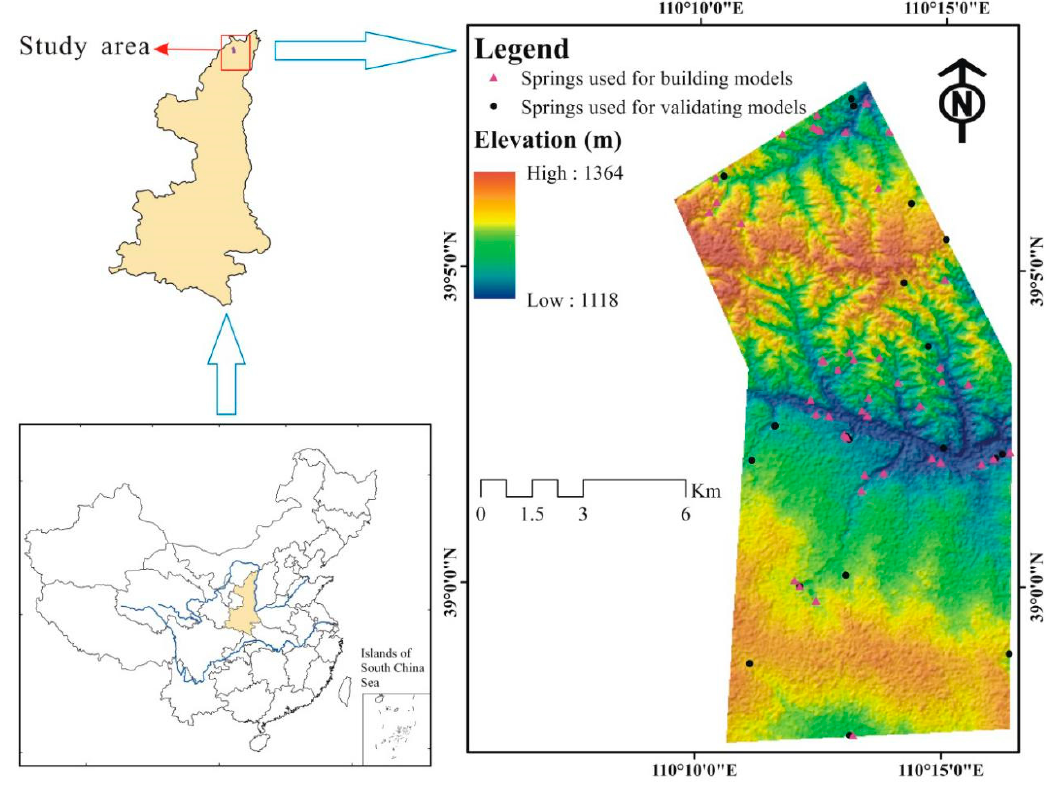
Figure 1. The study area.